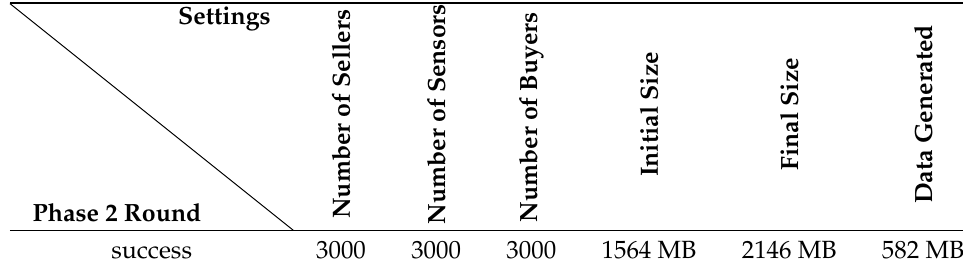
Table 7. Orderer data generation in successful Phase 2 round.